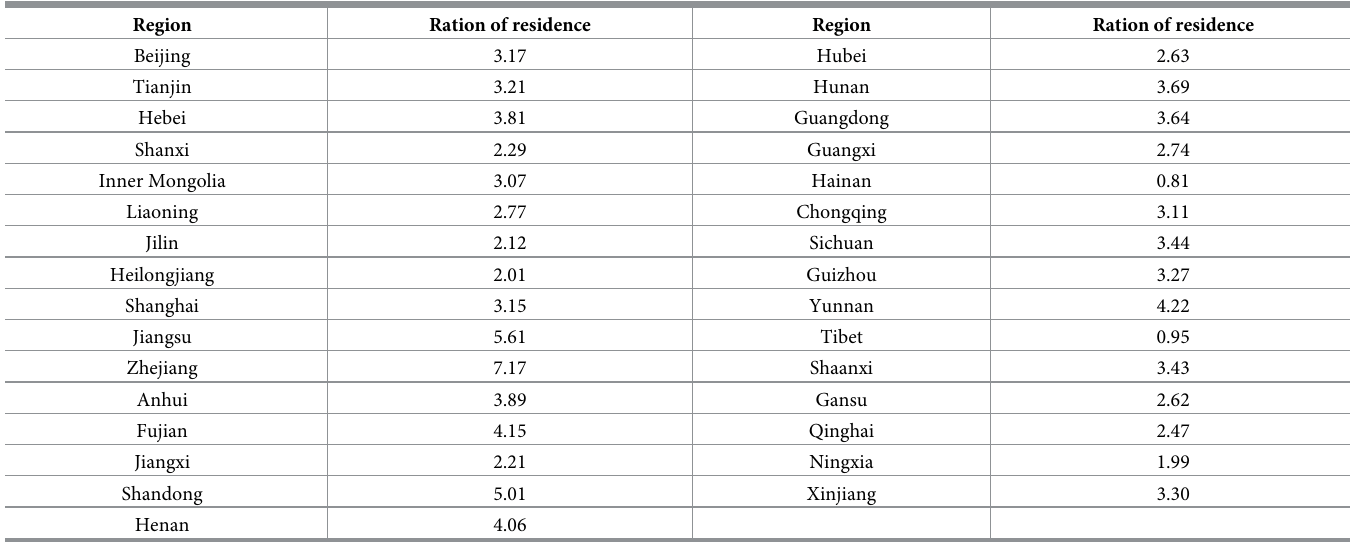
Table 2. Spatial distributions of sample provinces.